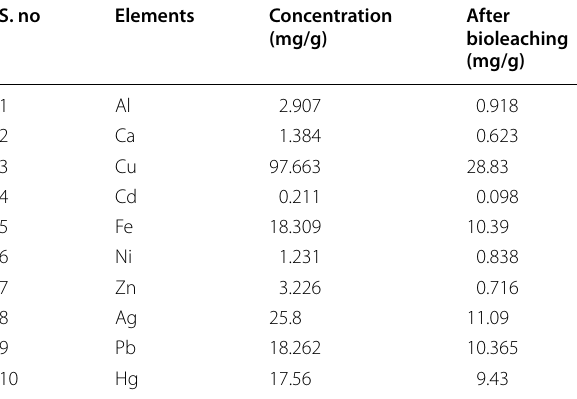
Table 1 Elemental composition of printed circuit board